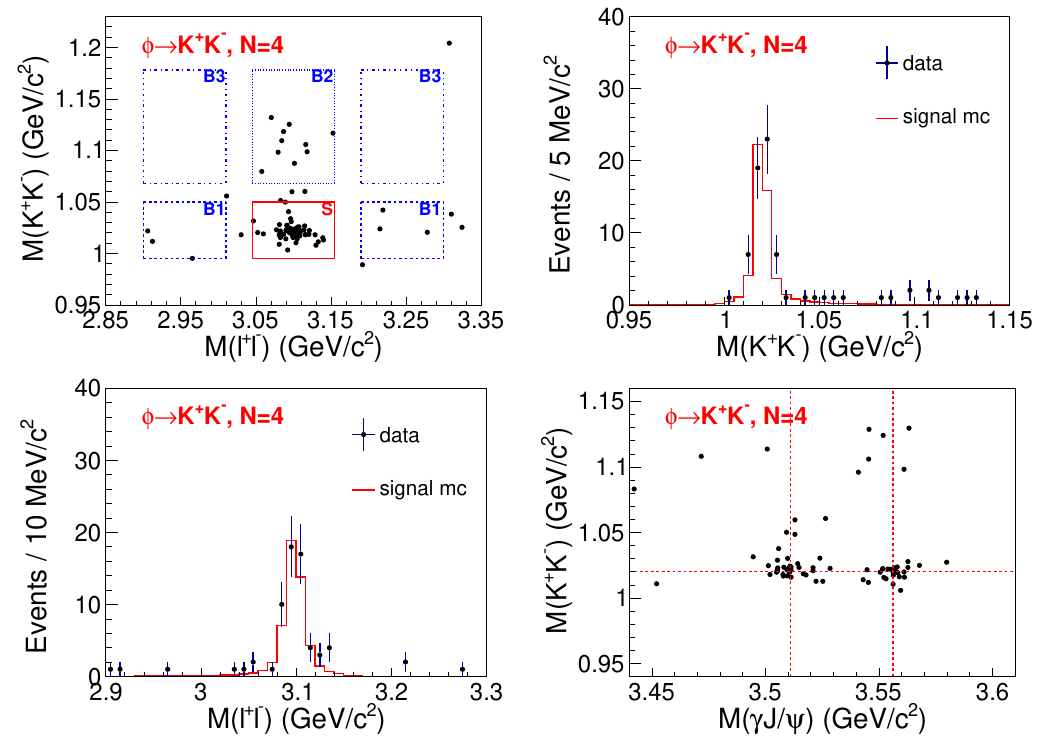
Figure 2 . The 2-dimensional distribution of the M ( K + K − ) versus M ( ‘ + ‘ − ) (upper left), the invariant mass distributions of the M ( K + K − ) (upper right), M ( ‘ + ‘ − ) (bottom left) and the 2- dimensional distribution of the M ( K + K − ) versus M ( γJ/ψ ) (bottom right) for the 4-track events in the φ → K + K − mode. Dots with and without error bars are the full data, the red histograms are the signal MC. In the upper left panel, the red solid box is the φJ/ψ signal region (S), the blue dashed, dotted and dash-dotted boxes indicate the φ non- J/ψ (B1), J/ψ non- φ (B2) and non- φ non- J/ψ (B3) sideband regions, respectively. The vertical (horizontal) dashed lines in the bottom right panel are central masses of χ c 1 /χ c 2 ( φ